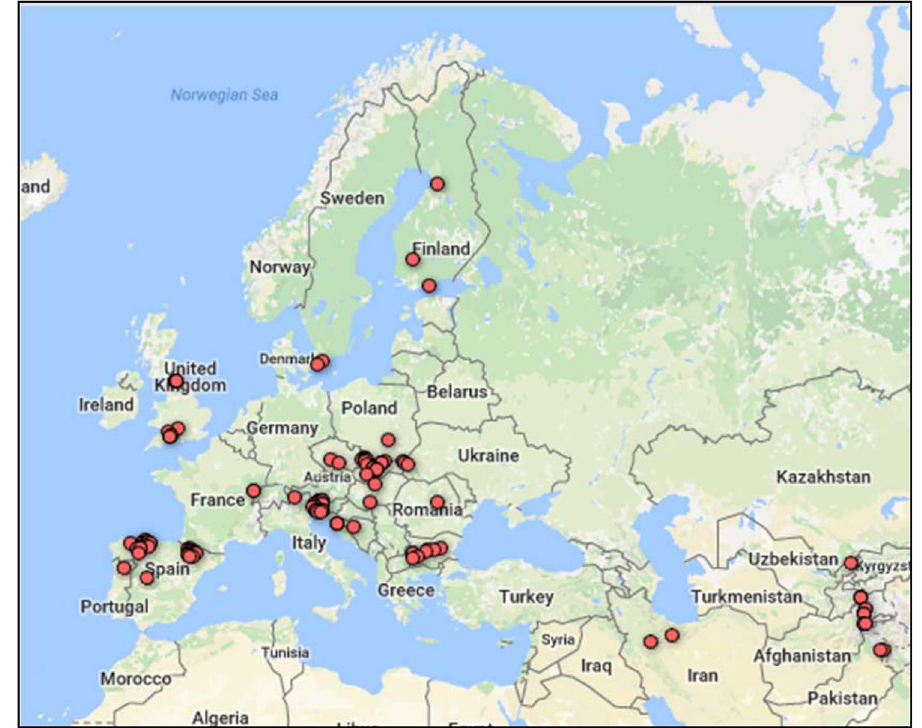
Figure 2. Map of collection sites of the ecotype accessions used for the red clover genetic diversity analysis. The data was accessed through Genesys Global Portal on Plant Genetic Resources, www.genesys-pgr.org, 2018-07-2, filtering for red clover and the holding institute GBR140. The plant genetic resources accession level data was provided by Aberystwyth University Plant Genetic Resources Unit.